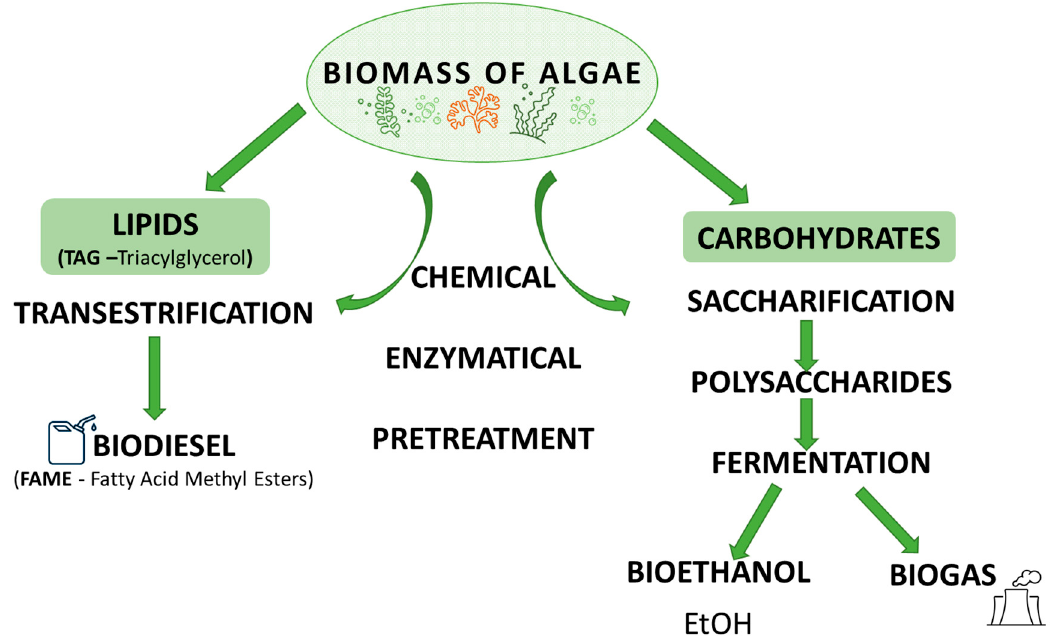
Figure 3. Algae biomass pretreatment methods were applied in order to obtain carbohydrates and lipids present in algae cells. Groups of macromolecules undergo further chemical processes to obtain the selected type of biofuel.